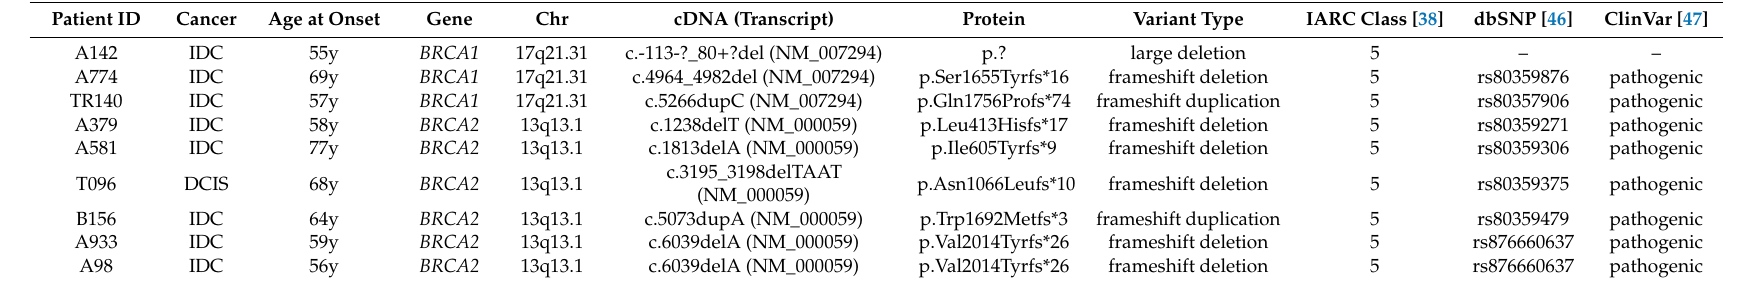
Table 2. Carriers of BRCA1 / 2 pathogenic and likely-pathogenic variants.